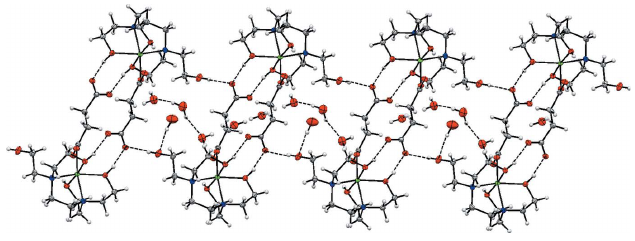
Figure 2 A view of the crystal packing of the title compound along the c axis. Dashed lines denote the intramolecular and intermolecular hydrogen